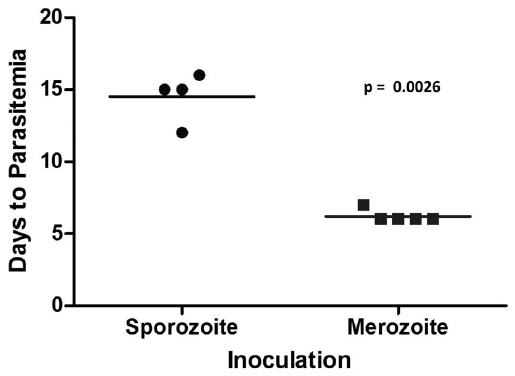
Figure 5. Prepatent period: sporozoite vs. merozoite inocula- tion. Days to first detectable parasitemia for immunocompetent and SCID foals inoculated intravenously with sporozoites was compared with that for historical SCID controls inoculated with merozoite- parasitized erythrocyte stabilates [35,36], using a t test ( a =0.05).